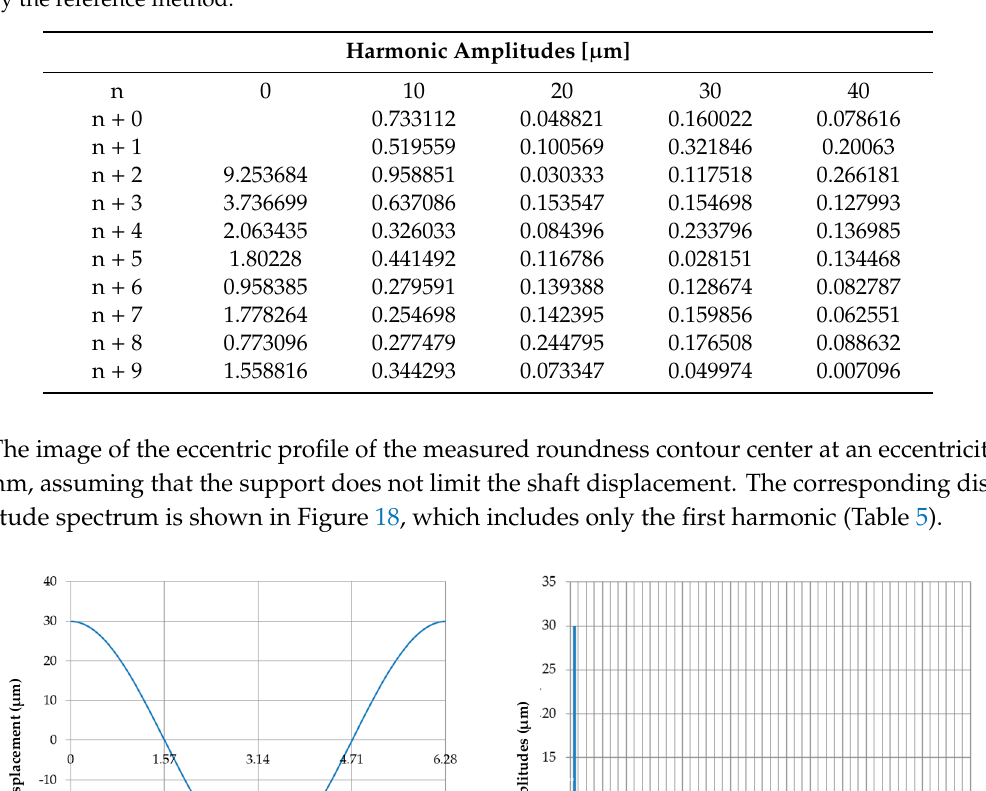
Figure 17. Roundness profile of journal no. 5 measured by the reference method ( a ); the discrete amplitude spectrum ( b ). Table 4. Amplitudes of the harmonic components for the roundness profile of journal no. 5, measured by the reference method.